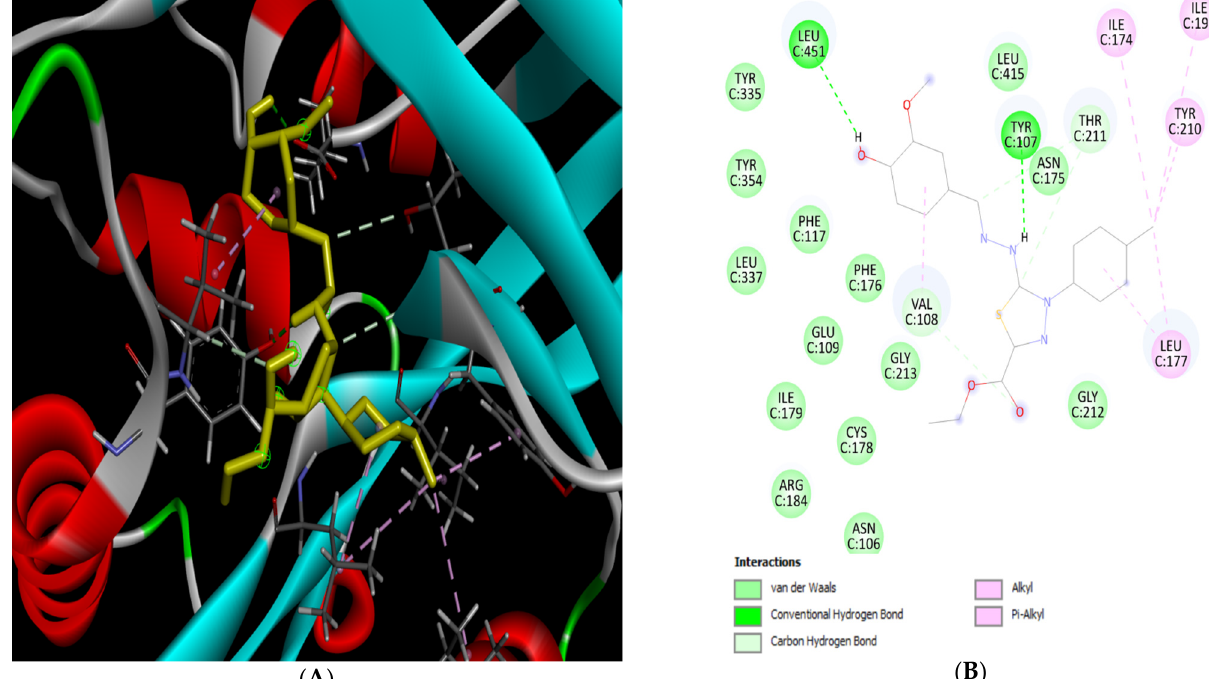
Figure 8. 2D ( B ) and 3D ( A ) representation of compound 5 docking with Nmt. Molecules 2021 , 26 , x FOR PEER REVIEW